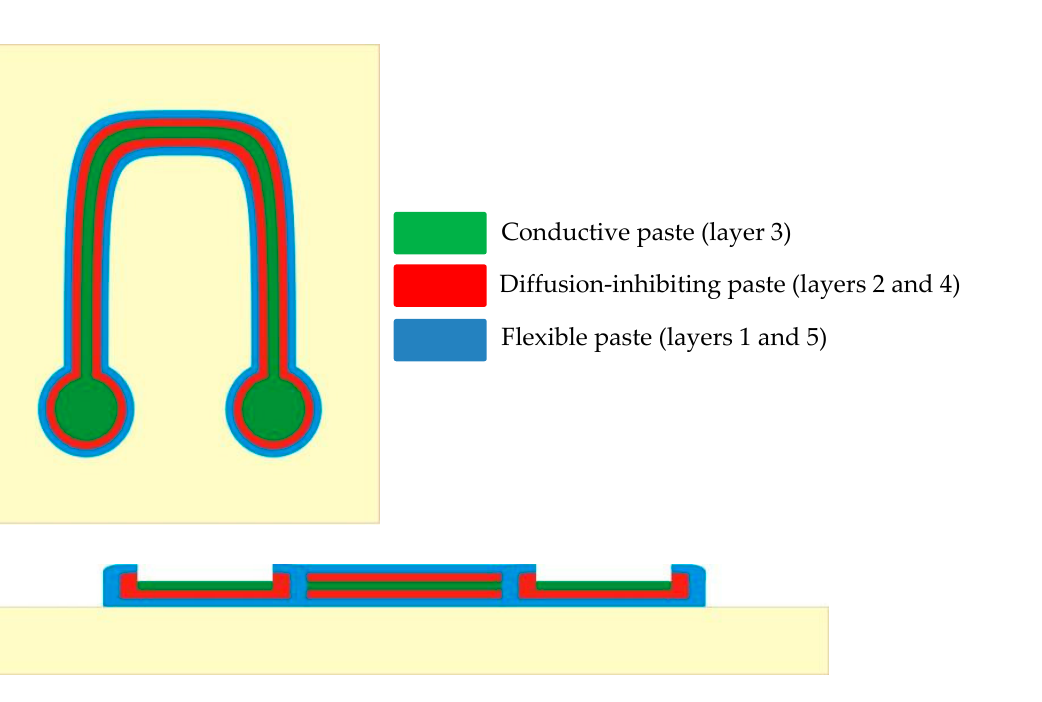
Figure 3. Top view and cross section of a printed sample. Table 1. Composition of the protective layers.